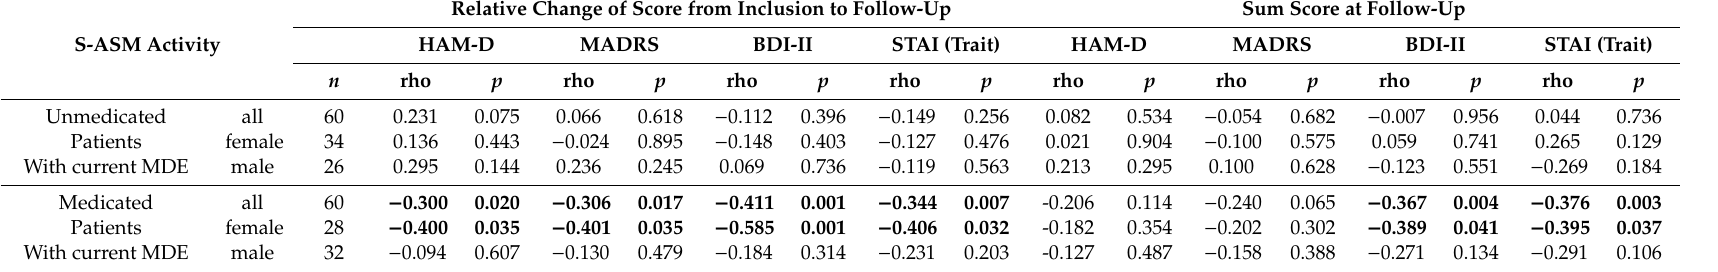
Table 3. Serum acid sphingomyelinase (S-ASM) activity at inclusion predicts relative change of depression severity and score at follow-up (approximately 3 weeks post inclusion) as assessed by rating by a clinician (HAM-D and MADRS) and self-rating (BDI-II), as well as relative change of the STAI-TRAIT score and score at follow-up in patients with a current major depressive episode